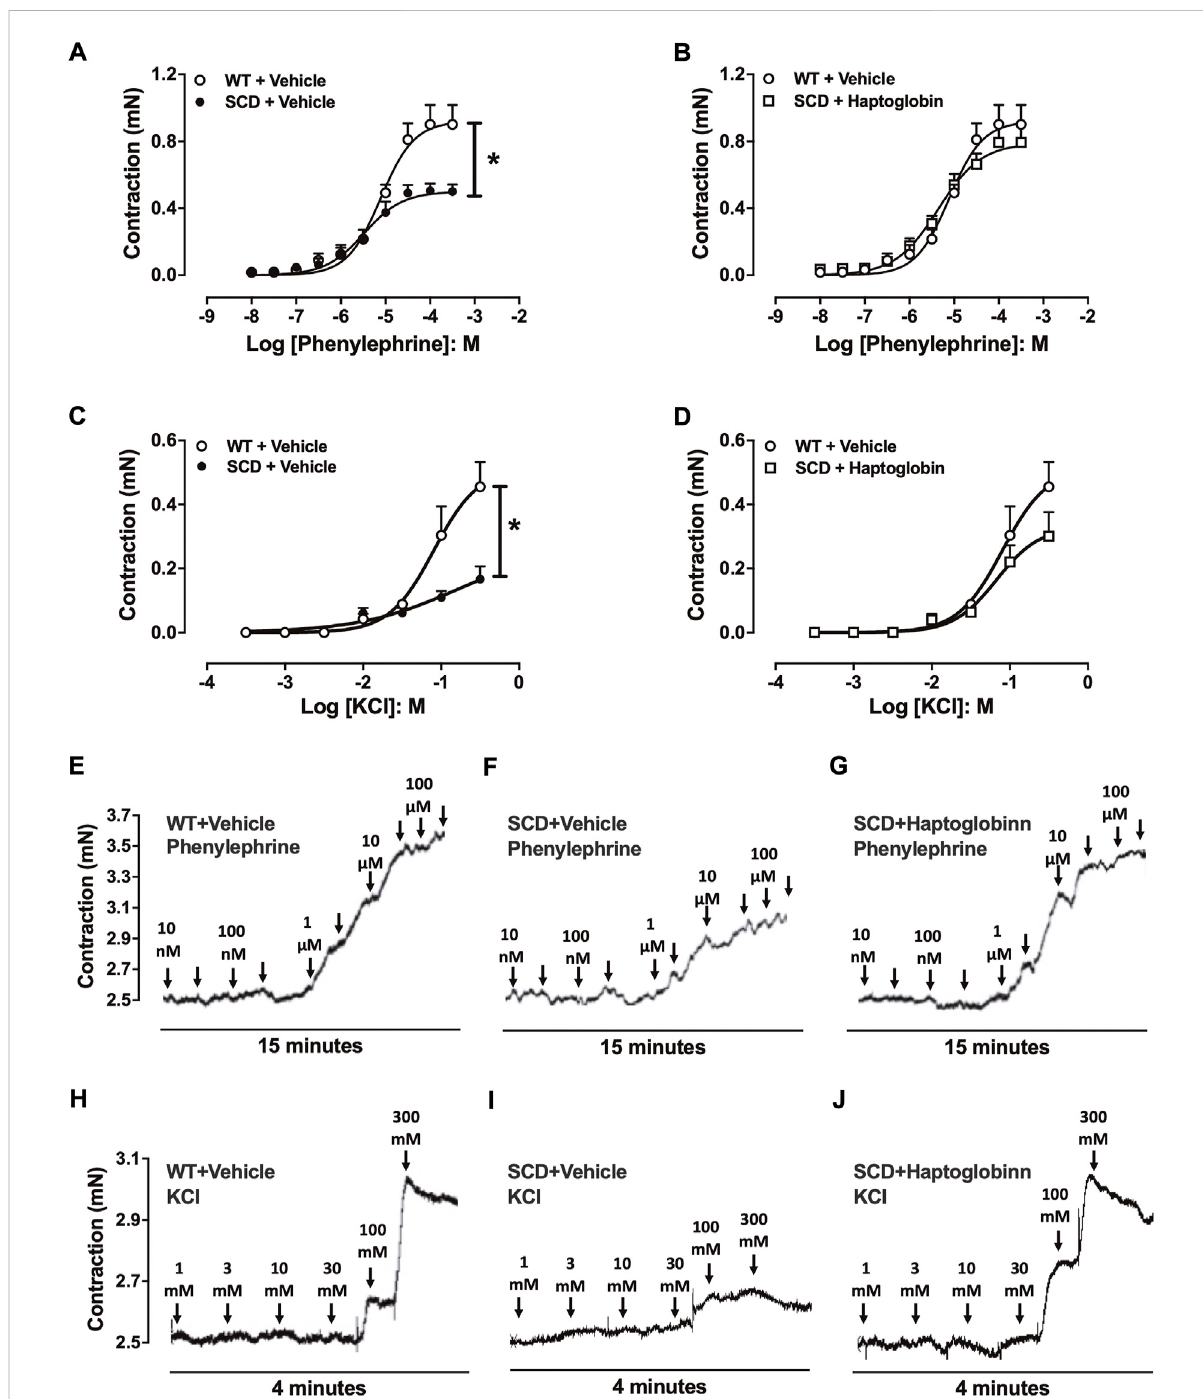
FIGURE 3 Concentration-response curves to phenylephrine (A,B) and KCl (C,D) in corpus cavernosum strips from WT and SCD mice treated or not with haptoglobin(Hap).DataareshowninmN,anddatarepresentthemean±SEMfor6miceineachgroup.* p < 0.05vs.WT-Vehicle.# p < 0.05vs.SCD- Hap.Representativetracingsofrelaxantresponsetophenylephrine (E – G) andKCl (H – J) incorpuscavernosumstripsfromWTandSCDmicetreated or not with